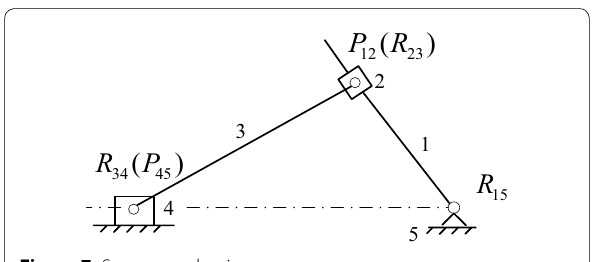
Figure 7 Source mechanism